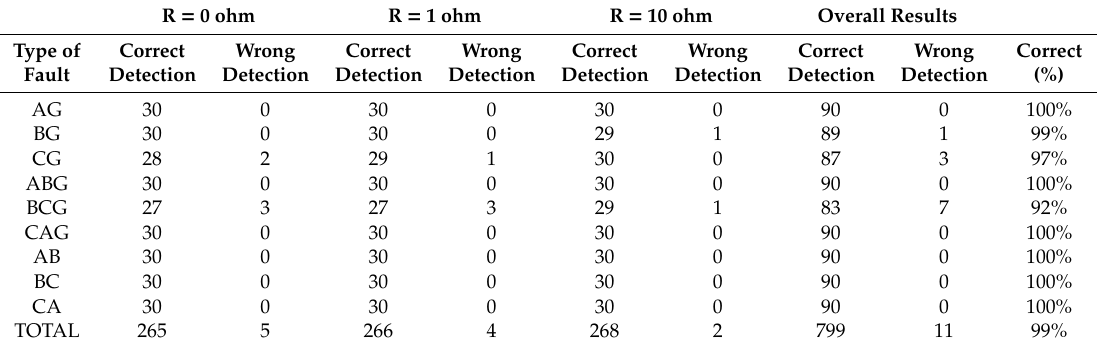
Table 5. Algorithm behaviour. Summary of results obtained for di ff erent faults fed by Type-4 WT.